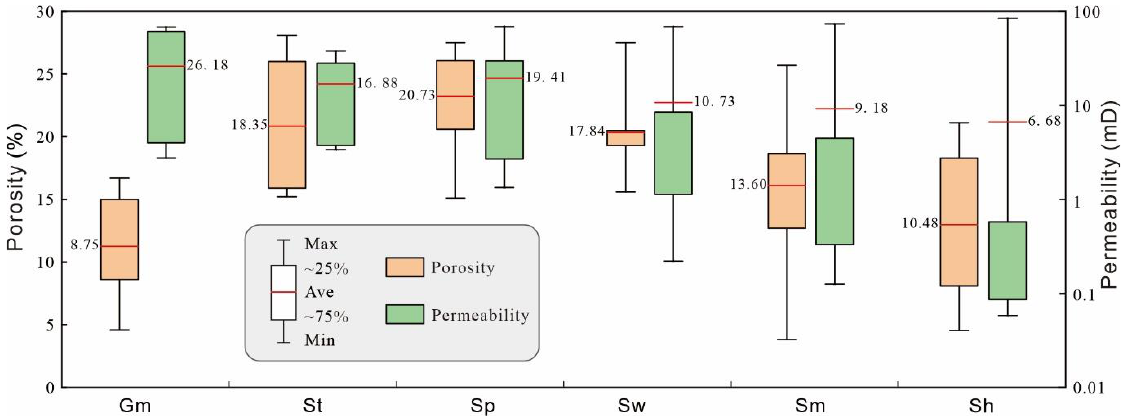
Figure 11. Characteristics of the various lithofacies of the Jiucaiyuan Formation in the Beisantai Uplift. Gm: massive bedding gravel; Sh: parallel bedded siltstone; Sm: massive bedded gravel; Sp: plane bedded sandstone; St: trough bedded sandstone; and Sw: wavy bedded sandstone.